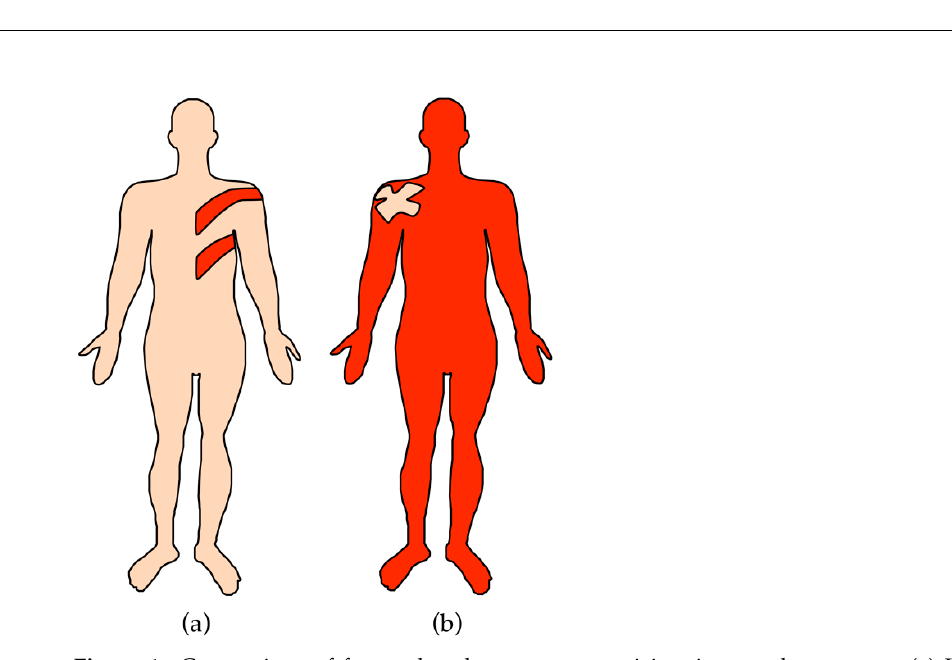
Figure 1. Comparison of forward and revertant mosaicism in genodermatoses. ( a ) In forward mosaicism, a somatic variant occurring on a wildtype allele induces a mosaic disease phenotype amidst otherwise healthy skin. ( b ) In revertant mosaicism, a somatic variant corrects the effect of a germline variant leading to the correction of the disease phenotype in a mosaic distribution. Light pink: healthy skin. Red: affected skin.